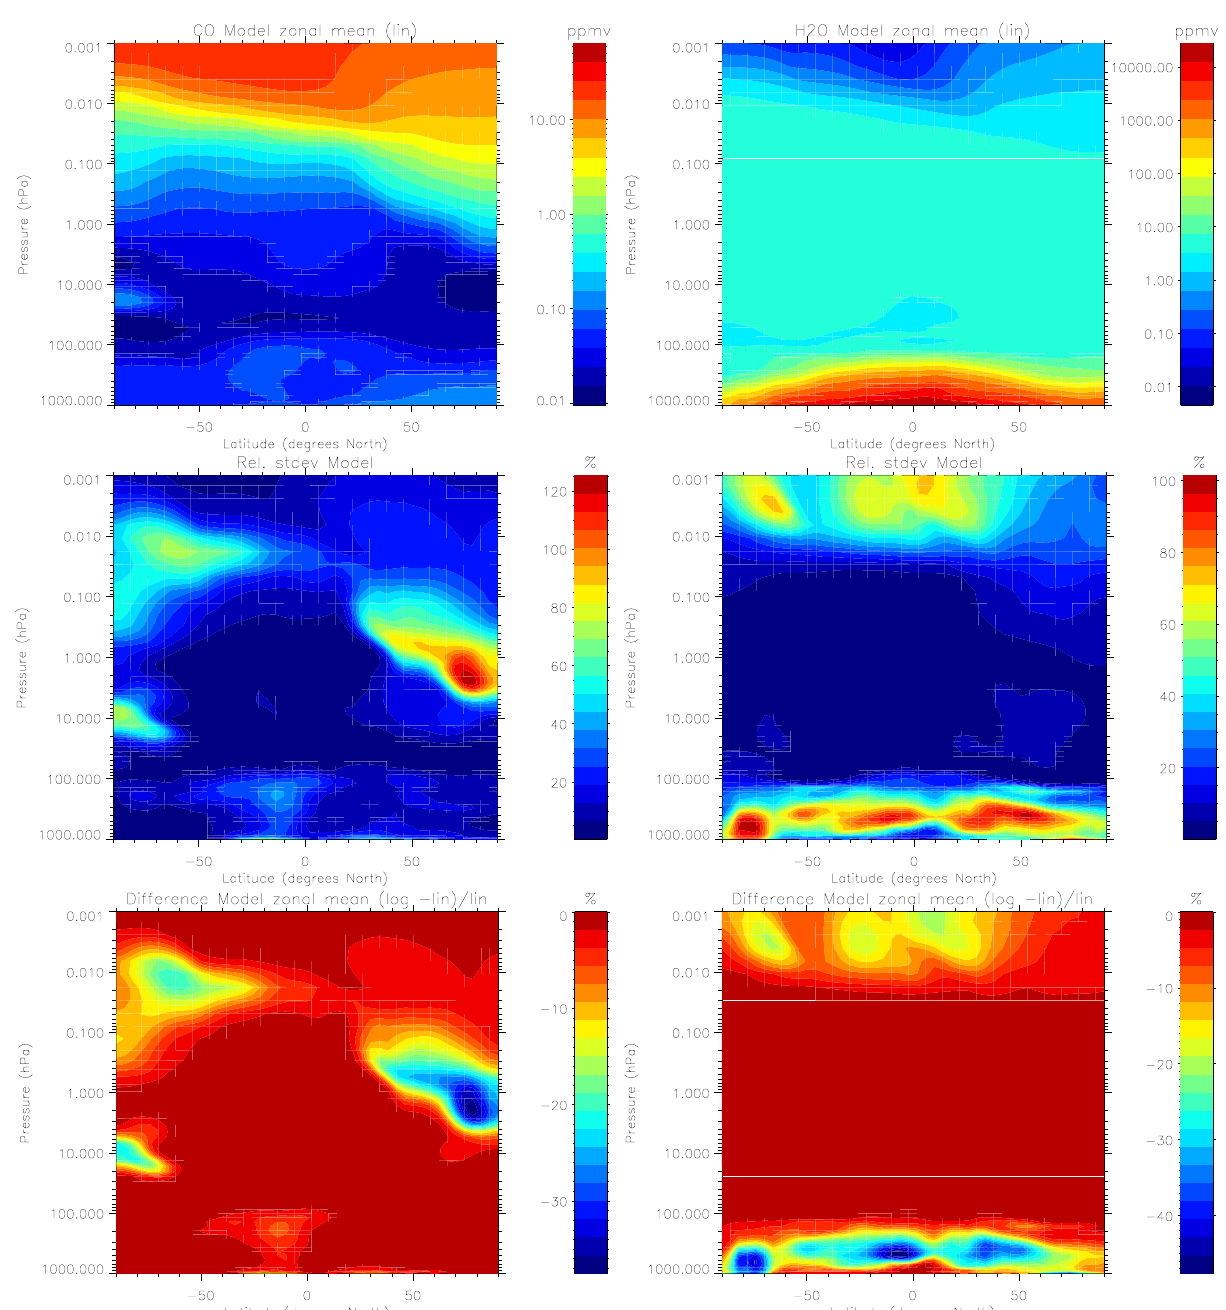
Fig. 1. Model zonal mean distributions of zonal mean vmrs (top), standard deviations (middle), and differences between linear and logarith- mically averaged means (bottom) for CO (left) and H 2 O